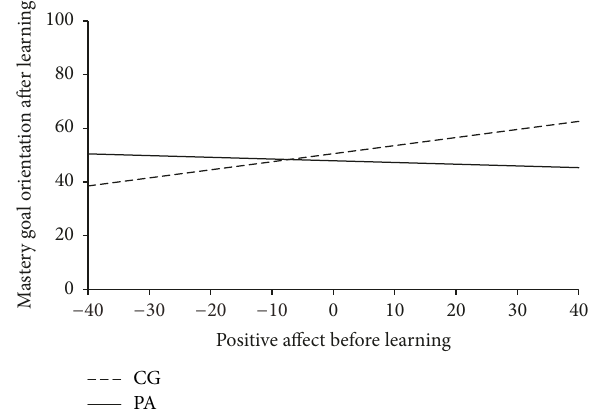
Figure 4: Regression of mastery goal orientation after learning on positive affect before learning for the control condition (CG) versus the positive affect (PA) condition. Positive affect before learning was centered and mastery goal orientation before learning is held constantly at the average